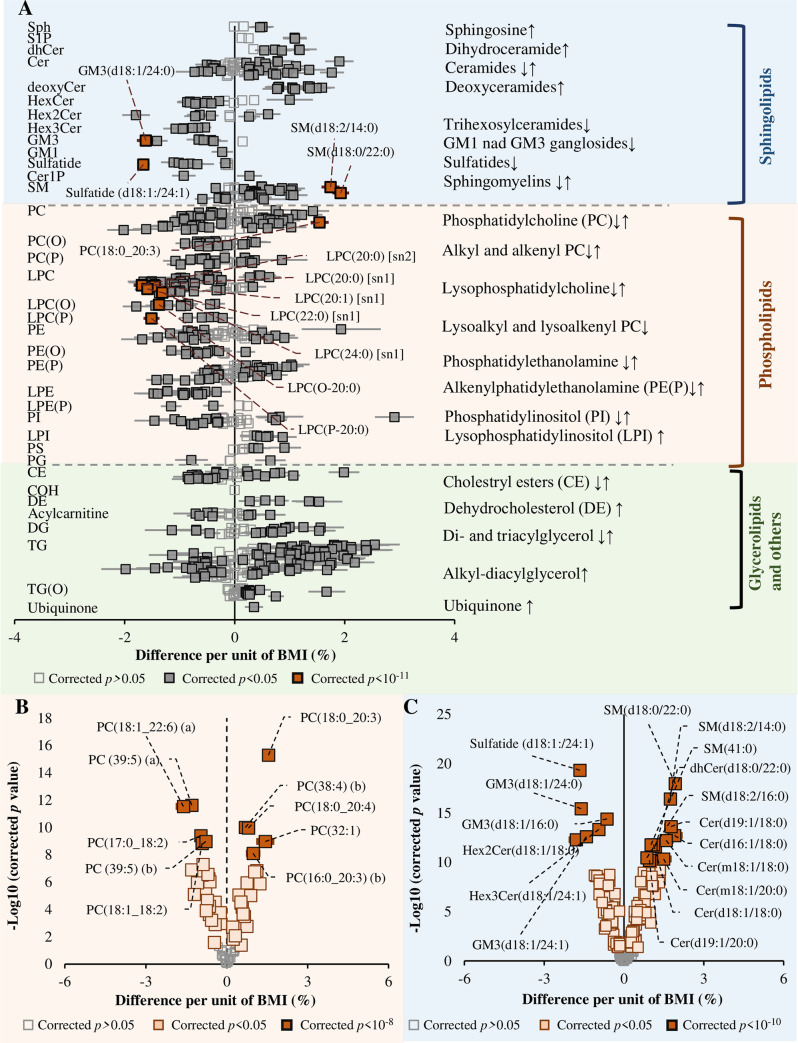
The association between BMI and the plasma lipidome.(A) Linear regression analysis between BMI and log-transformed lipid concentration was performed on 10,339 subjects adjusting for age, sex, total cholesterol, HDL-C, and triglycerides. Open squares show nonsignificant species, and grey and yellow closed squares show species with corrected p < 0.05 and species showing most significant associations (corrected p < 1 × 10−11), respectively. Error bars represent the 95% confidence interval. (B) The association of BMI with PC species and (C) the association of BMI with sphingolipid species. In panels B and C, the grey, pale tan, and dark tan squares indicate lipid species with corrected p-value greater than 0.05 or less than 0.05 and most significant, respectively. See S1 Data for the underlying data. BMI, body mass index; CE, cholesteryl ester; Cer, ceramide; Cer-1-P, ceramide-1-phosphate; COH, free cholesterol; DE, dehydrocholesterol; deoxyCer, deoxyceramide; DG, diacylglycerol; dhCer, dihydroceramide; GM1, GM1 ganglioside; GM3, GM3 ganglioside; HDL-C, high-density lipoprotein cholesterol; HexCer, monohexosylceramide; Hex2Cer, dihexosylceramide; Hex3Cer, trihexosylceramide; LPC, lysophosphatidylcholine; LPC(O), lysoalkylphosphatidylcholine; LPC(P), lysoalkenylphosphatidycholine; LPE, lysophosphatidylethanolamine; LPE(P), lysoalkenylphosphatidylethanolamine; LPI, lysophosphatidylinositol; PC, phosphatidylcholine; PC(O), alkylphosphatidylcholine; PC(P), alkenylphosphatidylcholine; PE, phosphatidylethanolamine; PE(O), alkylphosphatidylethanolamine; PE(P), alkenylphosphatidylethanolamine; PG, phosphatidylglycerol; PI, phosphatidylinositol; PS, phosphatidylserine; SM, sphingomyelin; sn, stereospecifically numbered; Sph, sphingosine; S-1-P, sphingosine-1-phosphate; TG, triacylglycerol; TG(O), alkyl-diacylglycerol.